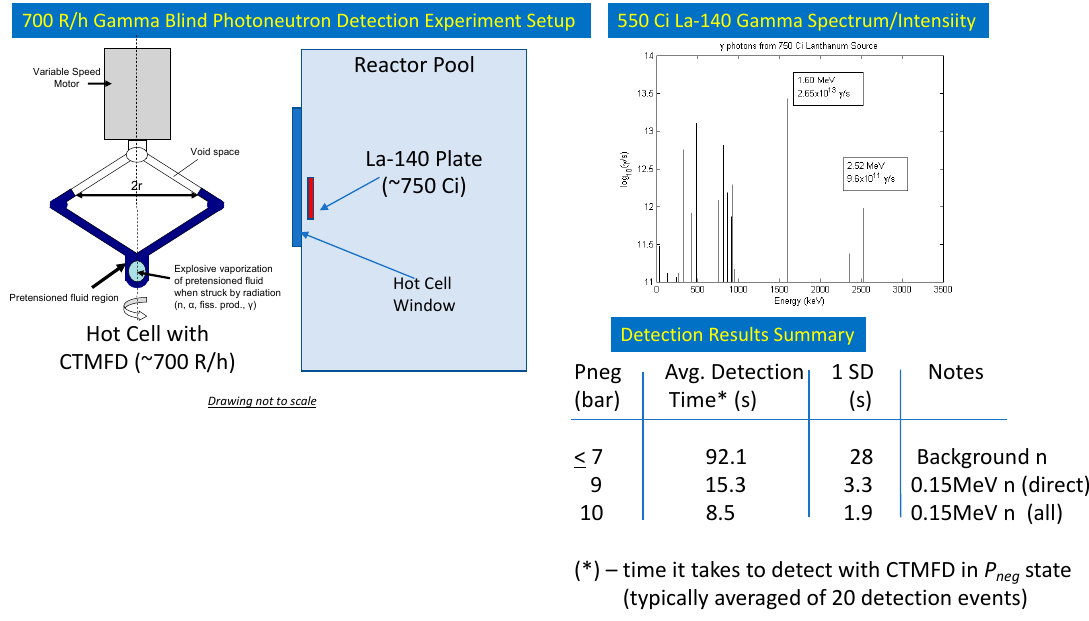
Figure 8. Schematic of experimental setup for qualifying the TMFD for gamma-blindness in 700 R / h multi-gamma energy field along with trace photoneutron spectroscopic detection.